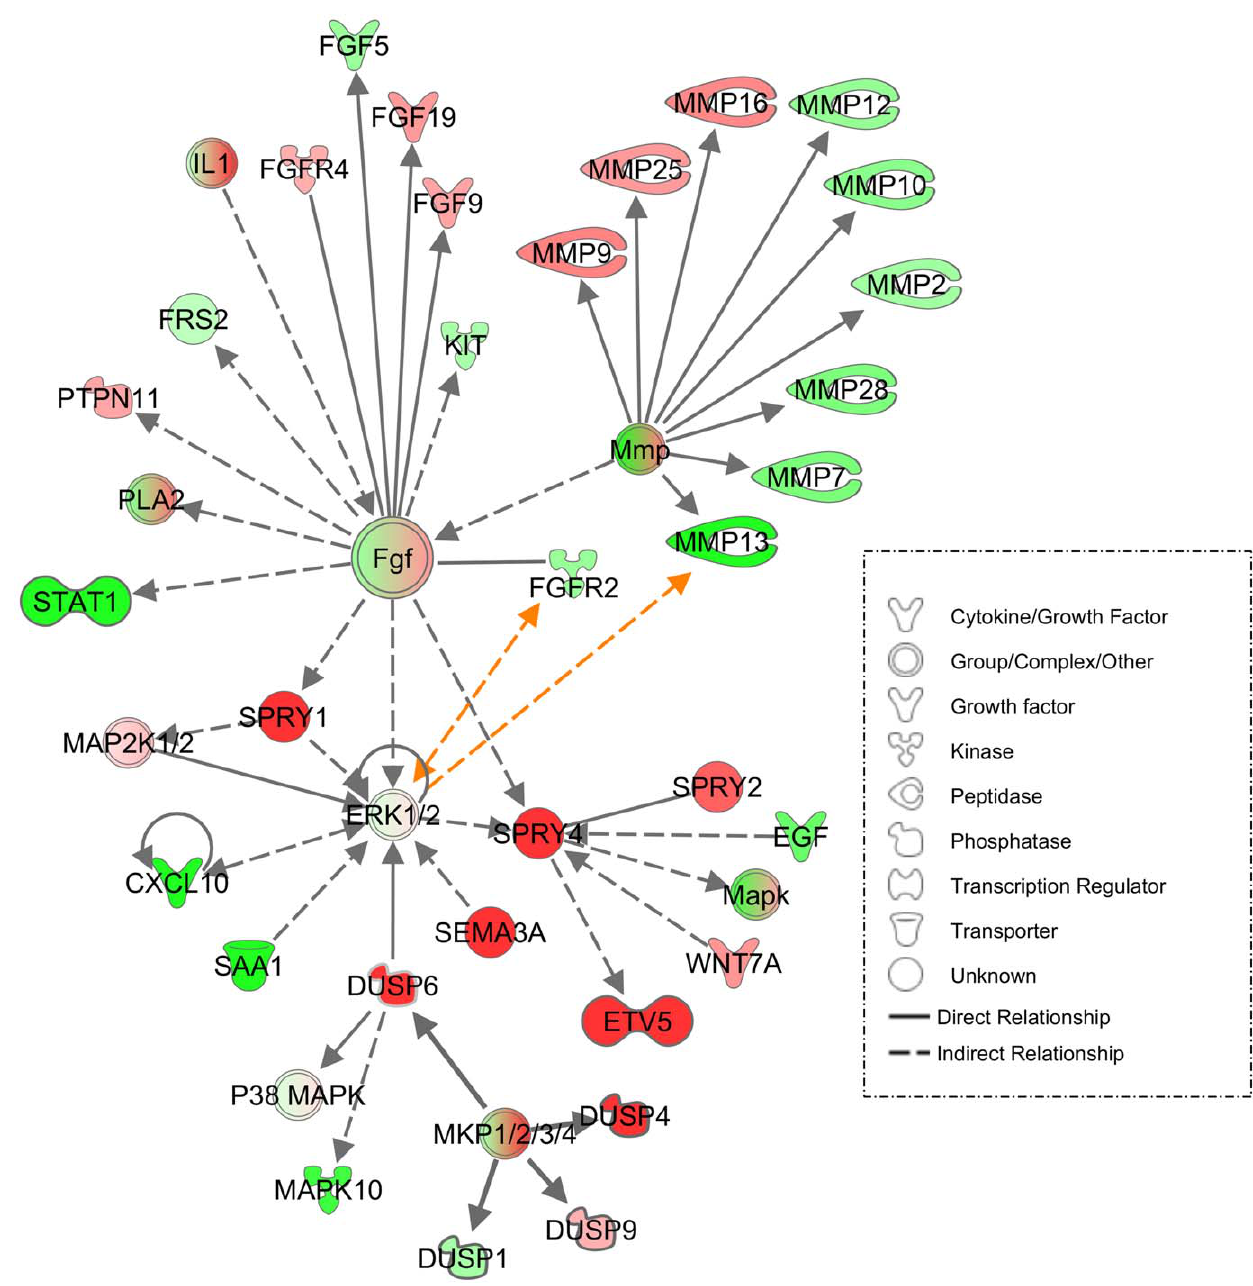
Figure 3. Dynamic molecular network induced by KGF in skin SCC cells. KGF-treatment of skin SCC cells induces up- and downregulation of variety of ERK1/2-regulated genes including upregulation of DUSP6 , ETV5 , SPRY1 , and SPRY4 genes. KGF also induces downregulation of MMP7 , MMP13 and CXCL10 . The data presented show KGF-induced changes as an average in three SCC cell lines. The image was generated using Ingenuity Pathways Analysis (IPA). The symbols represent gene function, as indicated in legend on the right. Red color indicates gene upregulation and green color downregulation by KGF. The genes with fold change . 1.5 are indicated with the strongest red (up) and green (down) colors. The rainbow color indicates a group of genes with up- or downregulation. Some of the groups (FGF, MMP, MKP1/3/4) are ‘‘opened’’ to show the regulation of individual genes. The arrows and lines indicate direct (solid line) and indirect (dashed line) physical and functional interactions. The arrows show the direction of regulation. The relations found in this study are highlighted with yellow